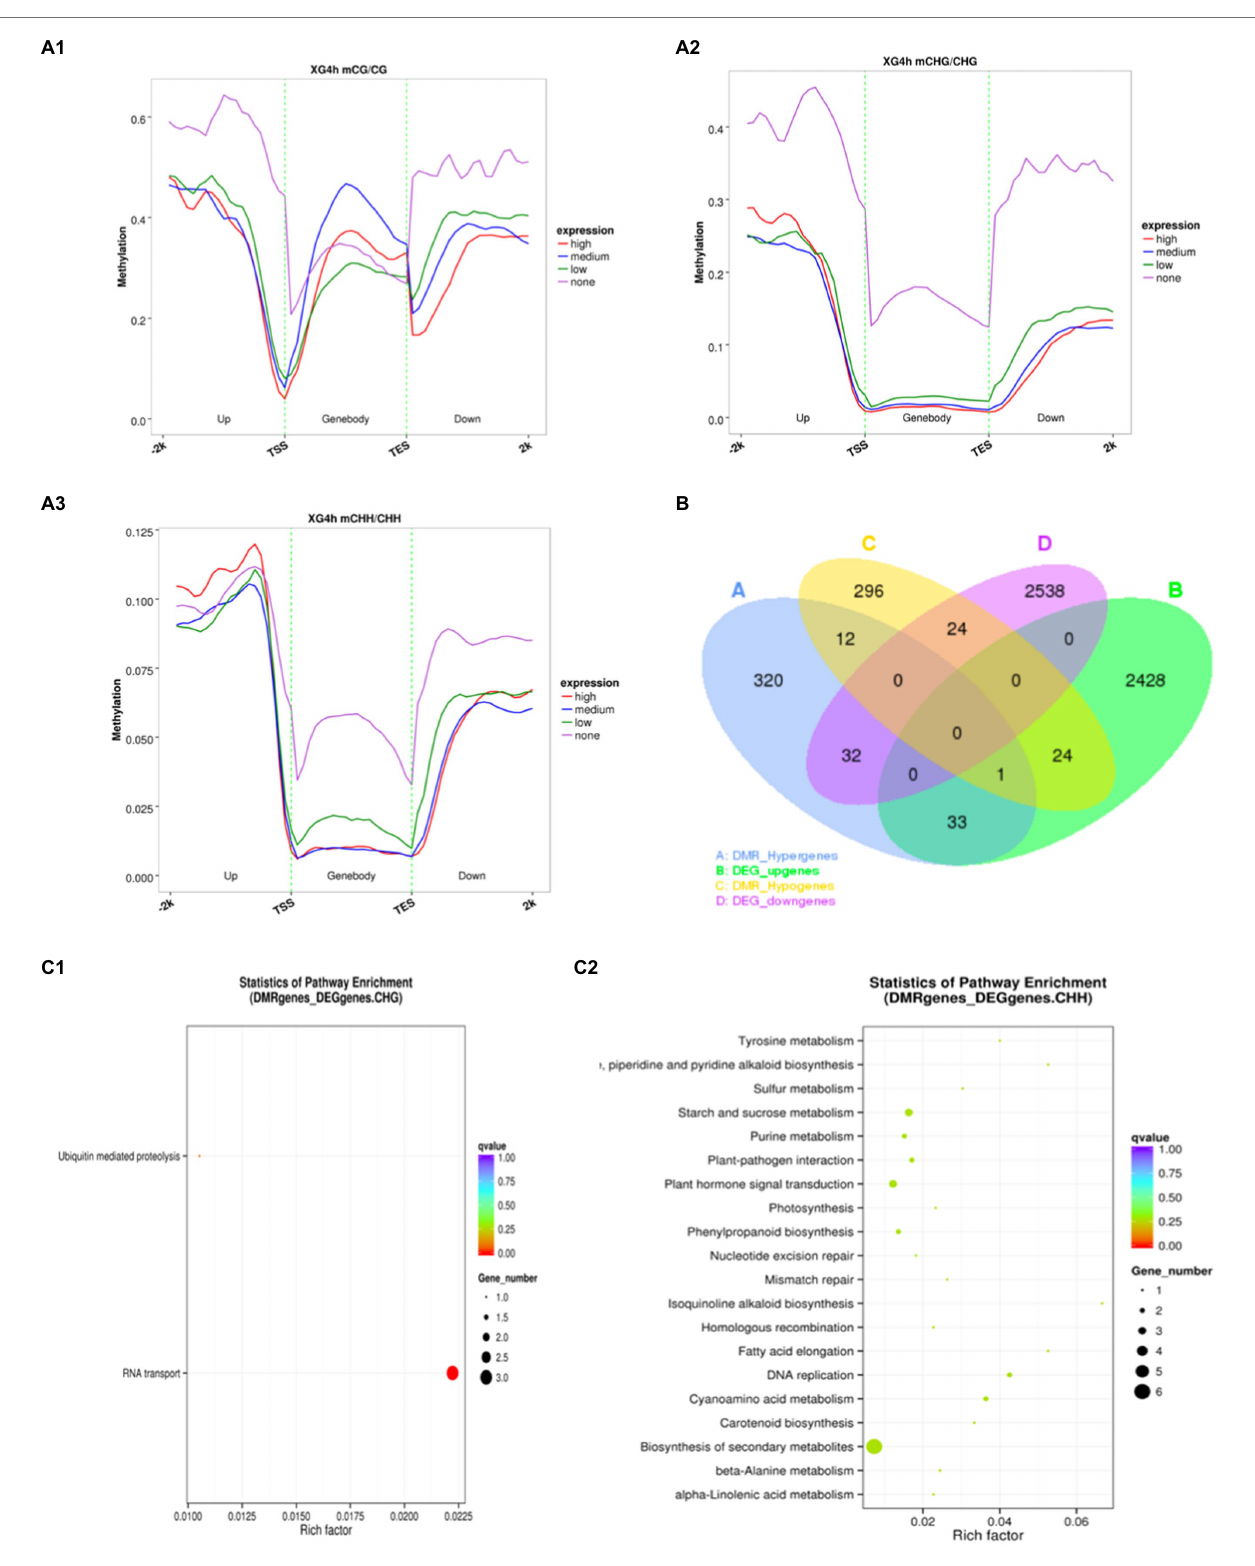
FIGURE 4 | Methylation and gene expression association analysis. (A) The relationship between methylation level and gene expression. (B) Venn diagram of DEGs and DMGs. (C) KEGG pathway enrichment of